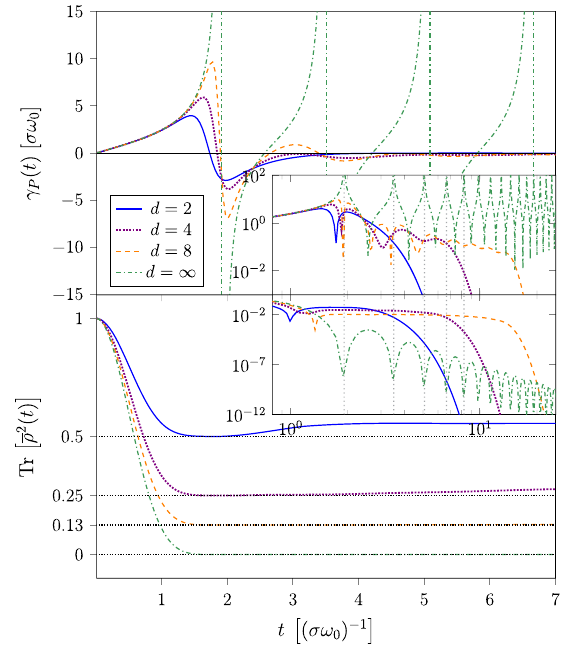
FIG. 4. Ensemble-average dynamics for the unitarily invariant Gaussian disorder ensemble. Top panel: GUE depolarization rate γ t Þ , [cf. Eq. (69)], for dimensions d ¼ 2 ; 4 ; 8 ; ∞ . Inset: GUE ð t Þ . For finite dimensions, the Double-logarithmic plot of γ GUE ð rate undergoes a finite number of oscillations and a subsequent exponential decay to zero from below. Bottom panel: Decay of the purity Tr ½ ¯ ρ 2 ð t Þ(cid:2) for a pure initial state, Tr ½ ρ 2 ð 0 Þ(cid:2) ¼ 1 . For finite dimensions, the asymptotic values of the purities correspond to Eq. (80), which is larger than 1 =d (indicated by horizontal, black, dotted lines). Inset: Double-logarithmic plot of the approach to the asymptotic state Tr ½ ¯ ρ 2 ð t Þ(cid:2) − lim t → ∞ Tr ½ ¯ ρ 2 ð t Þ(cid:2) . The purity oscillations are directly correlated with the oscillations t Þ (dotted, vertical, gray lines). Note that, for of the rates γ GUE ð finite dimensions, the peaks are shifted with respect to their t Þ in the top inset because of the corresponding rates γ GUE ð subtraction of the asymptotic purity